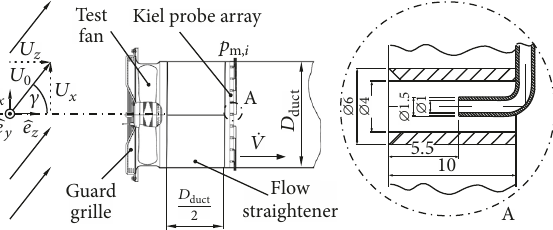
Figure 4: Measuring setup with Kiel probe array (FD-SI-GG).